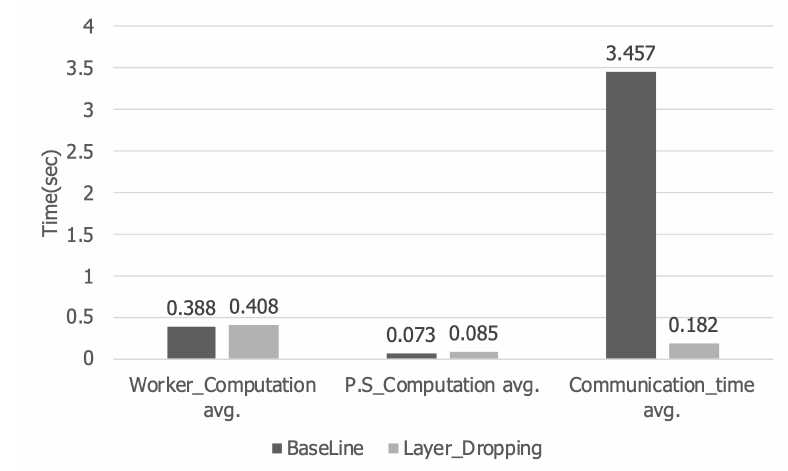
Figure 8. Training accuracy over time in a low bandwidth network.